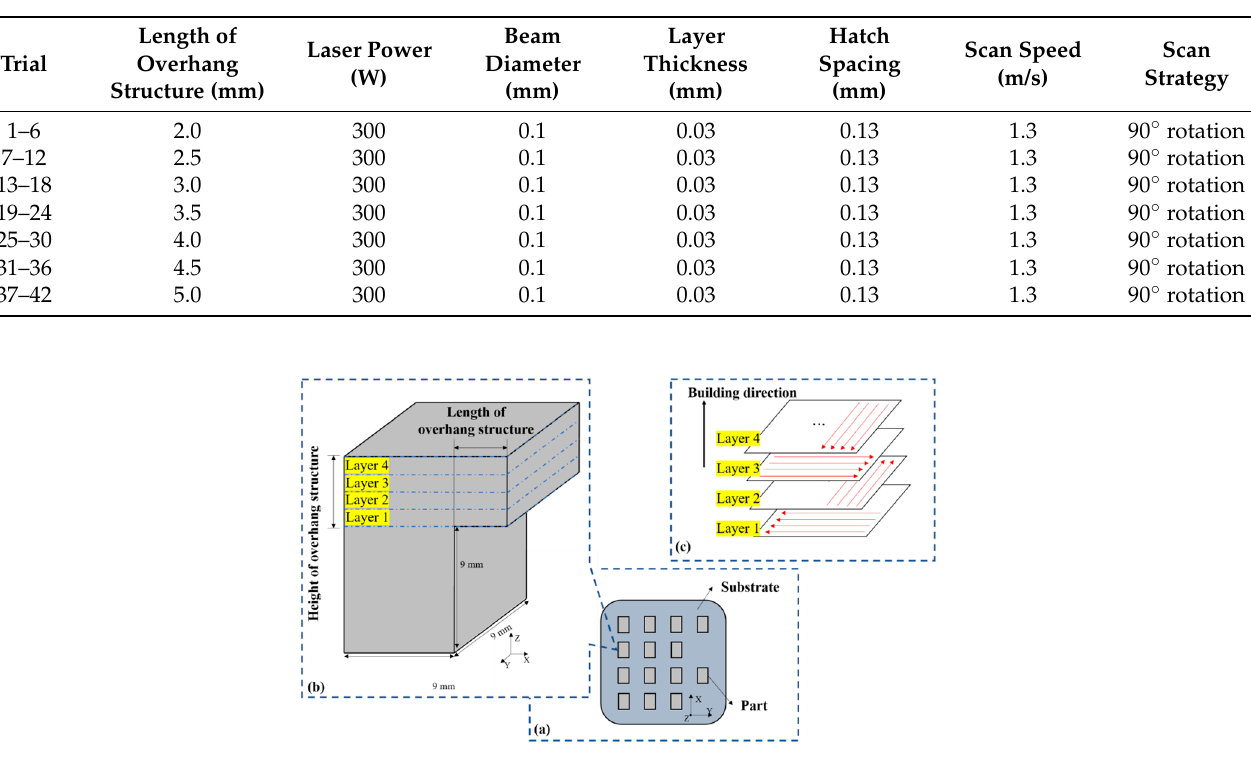
Figure 1. Illustration of part shapes and scanning strategy: ( a ) the distribution of parts on the substrate; ( b ) the shape of sample parts; and ( c ) 90° scanning strategy.